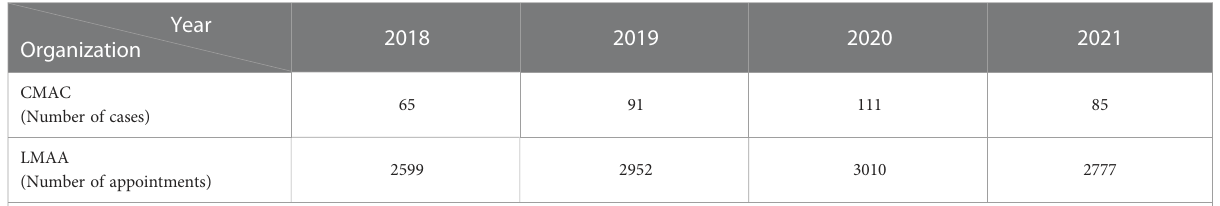
TABLE 1 caseload statistics of two leading maritime arbitration organizations in PRC and